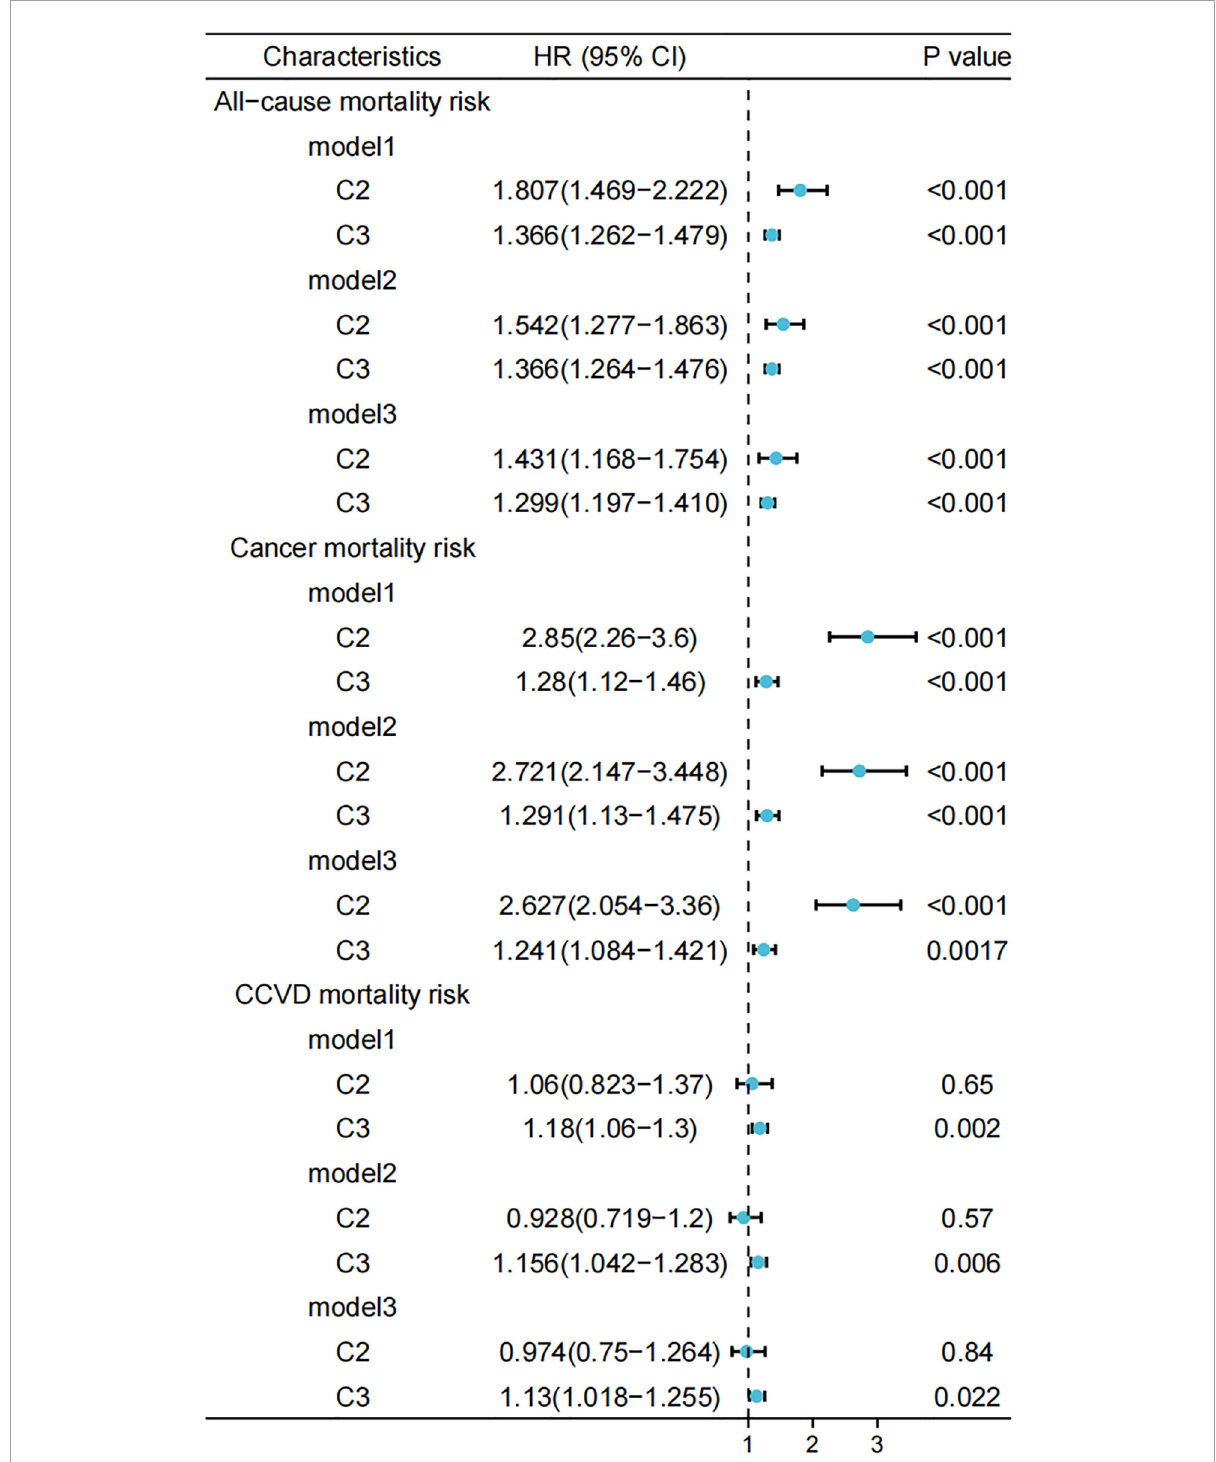
FIGURE7 Relationship between different scores and risk of all-cause/cancer/cardiovascular and cerebrovascular diseases (CCVD) mortality. Standardized scores were divided into four groups (Q1, Q2, Q3, and Q4) according to the 25th, 50th, and 75th quartiles, with the Q1 group used as a reference. Model 1 was unadjusted for variables and Model 2 was adjusted for age, sex, race, marital status, and household income at baseline; Model 3 was further adjusted for history of hypertension, hyperlipidemia, and diabetes. GNRI, geriatric nutritional risk index; DII, dietary inflammatory index; HEI, healthy eating